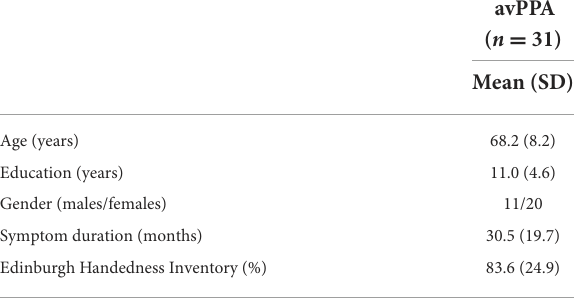
TABLE 1 Demographical and clinical features of the avPPA